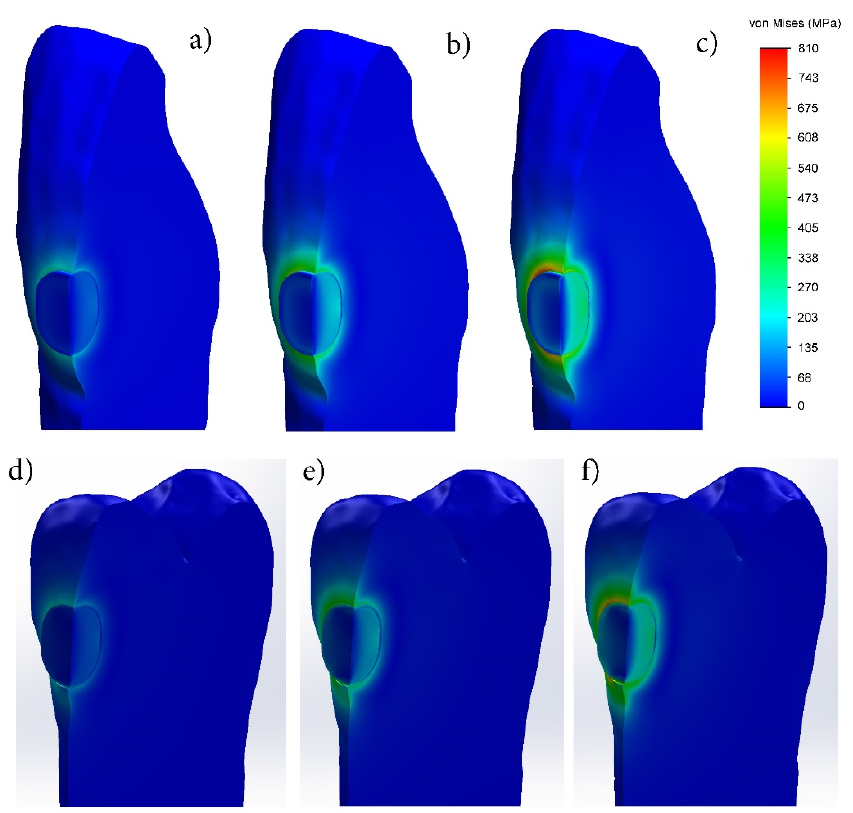
Figure 3. Distribution of equivalent Von Mises stresses during setting process of fillings made with: ( a ), ( b ), ( c ) glass-ionomer cement; (d), (e), (f) flowable photo-cured composite (FPC). (1% shrinkage – ( a ), ( d ); 2% shrinkage – ( b ), ( e ); 3% shrinkage – ( c ), ( f )).